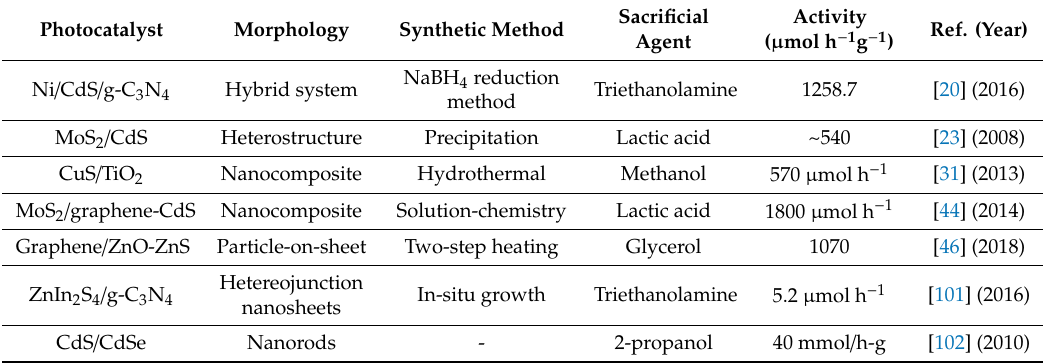
Table 10. Photocatalytic activity of photocatalysts using different sacrificial agents